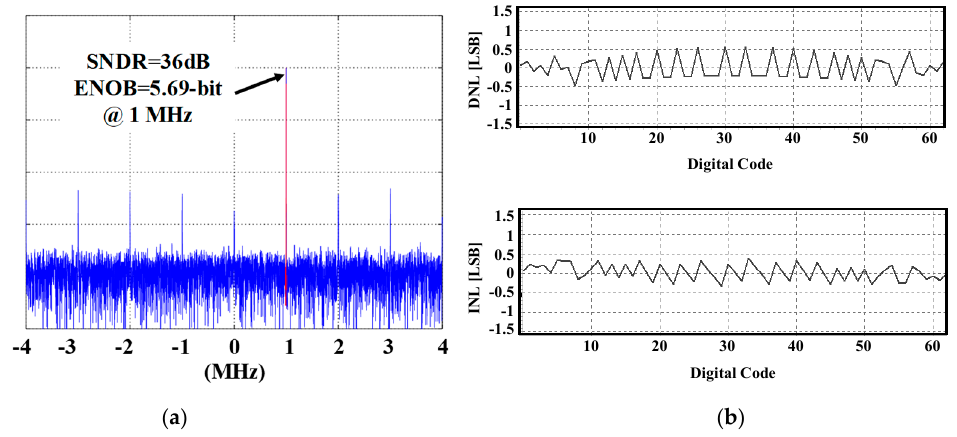
Figure 27. The measured ( a ) ENOB and ( b ) INL and DNL of ADC.